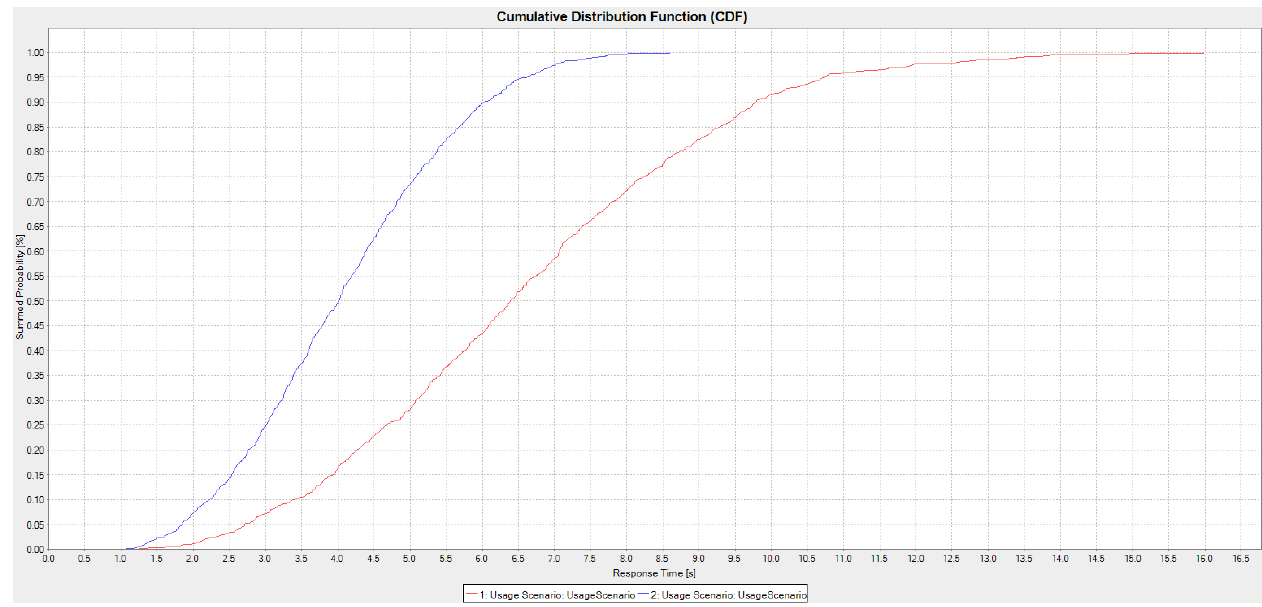
Figure 10. Comparison between the response time of the usage scenario from the original architecture (red curve) and the alternative design (blue curve).